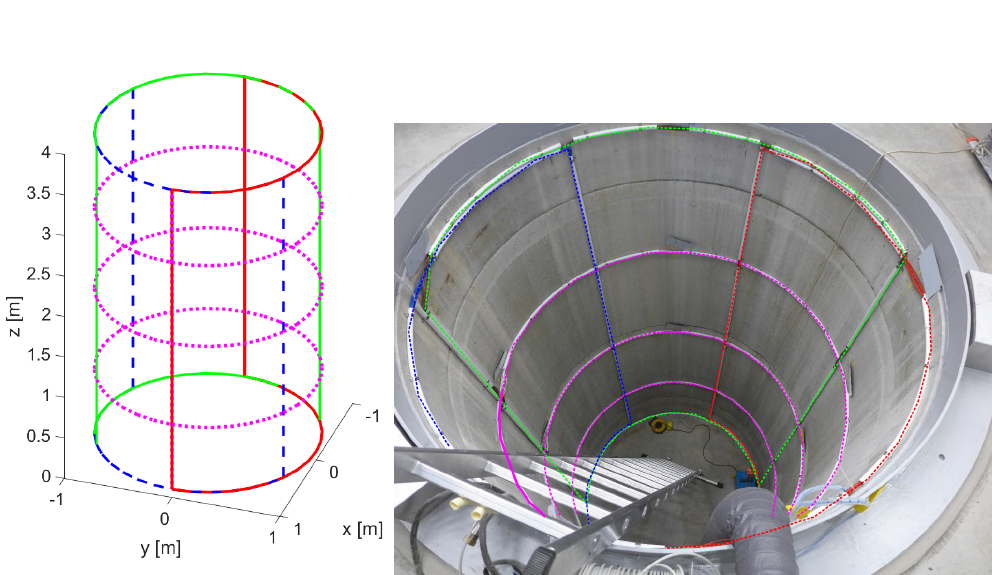
Figure 2. ( Left ): the geometry with the three axial coils in magenta and the three axial coils colored red, green, and blue. ( Right ): photograph of the coils (with superimposed colors), enclosed in plastic pipes and installed in the hole for the cryostat. The axial coil arcs, connecting the vertically mounted radial coils, are visible near the top and the bottom of the hole.